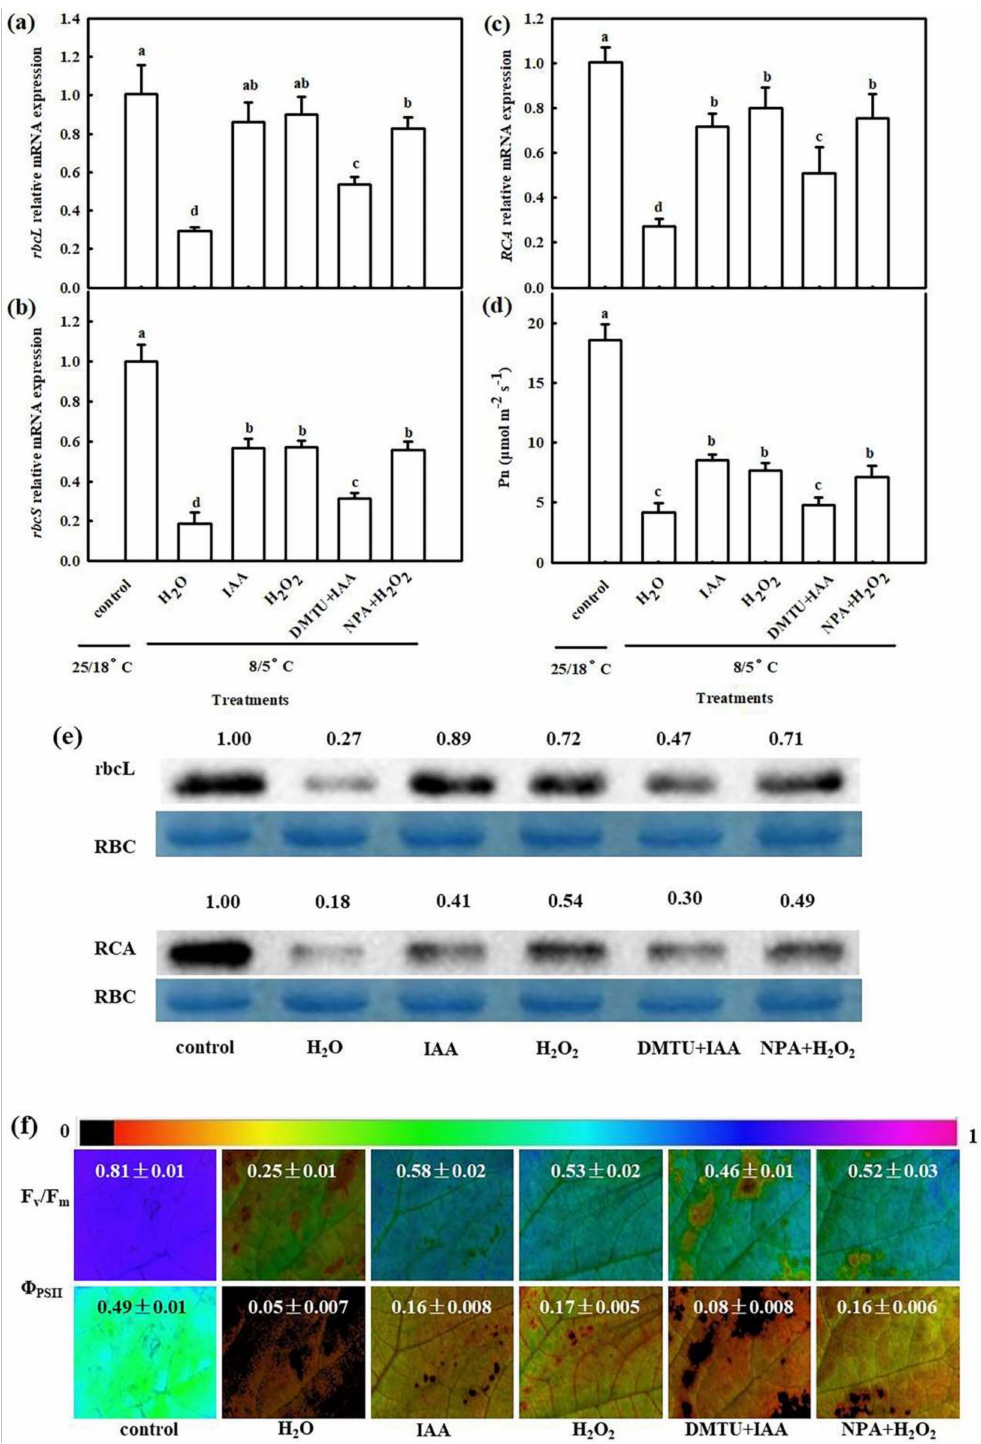
Figure 4. Interactive effects of IAA and H 2 O 2 on mRNA abundances of rbsL , rbcS, and RCA , and protein levels of rbsL and RCA in cucumber seedlings under chilling stress. ( a – c ) mRNA abundances of rbcL , rbcS, and RCA ; ( d ) Pn; ( e ) Protein levels of rbcL and RCA; ( f ) Image of F v / F m and Φ PSII . The false color code depicted at top of the image represents the degree of photoinhibition at PSII. Cucumber seedlings were pretreated with 75 µ M IAA, 1.0 mM H 2 O 2 , 5.0 mM DMTU +75 µ M IAA, 50 µ M NPA +1.0 mM H 2 O 2 , or deionized water (control) for 24 h, and subsequently exposed to 5 ◦ C for 24 h. The data represent the mean ± SD of three biological replicates. Different letters indicate significant differences ( p < 0.05), according to Duncan’s new multiple range